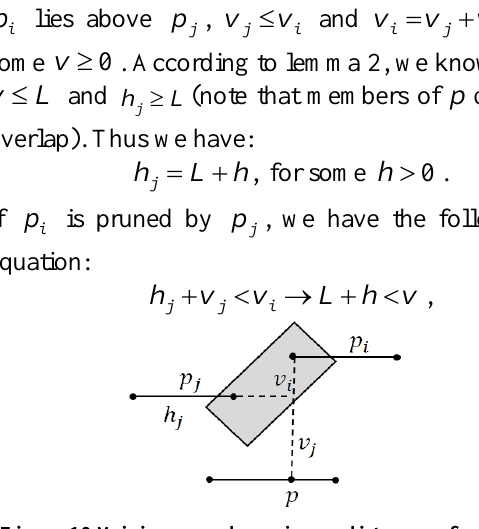
Maxq , a , b , and c used in proof of 1 lemma 2.